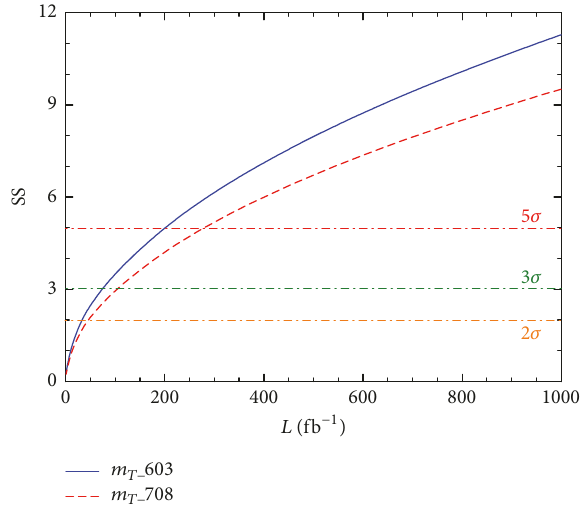
Figure 6: The statistical significance depending on integrated luminosity for √𝑠 =